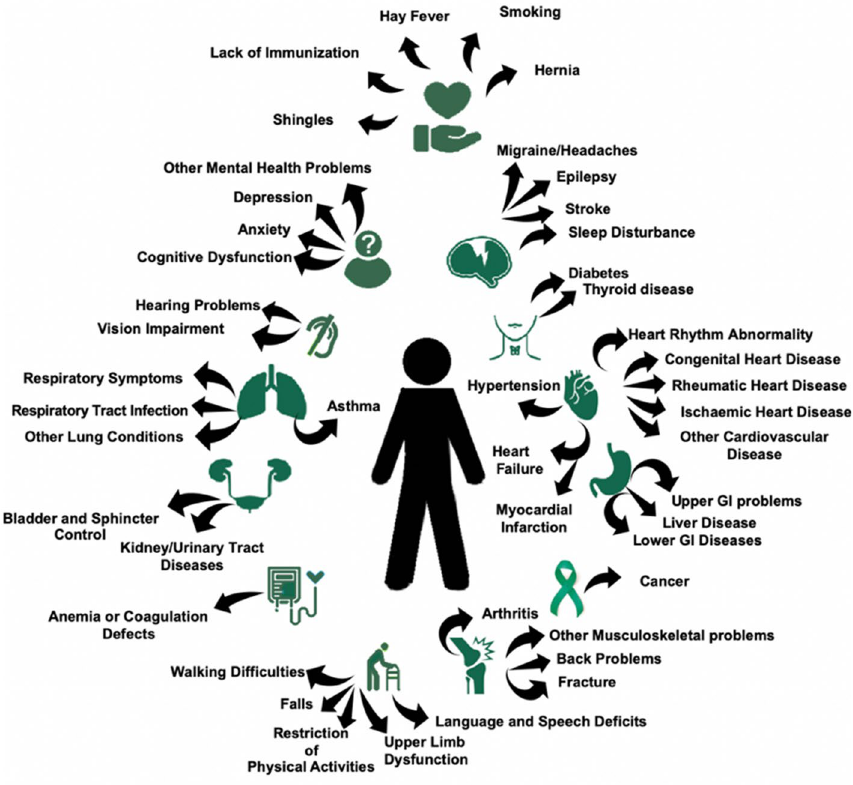
Figure 1. The 45 health deficit categories, spanning a broad set of physical and cognitive domains, appraised in MRC NSHD 1946 British birth cohort participants. MRC NSHD Medical Research Council National Survey of Health and Development, GI